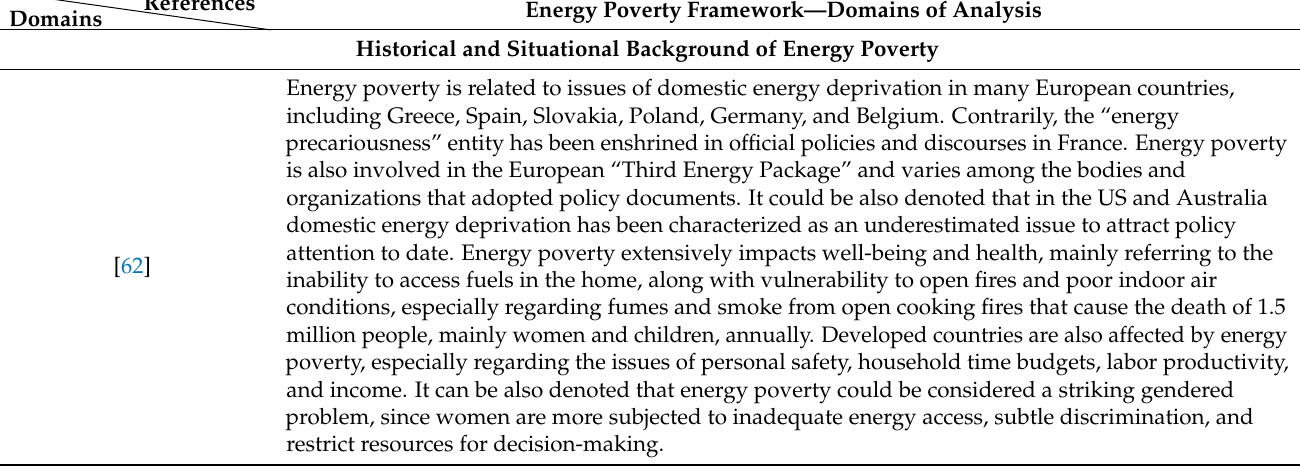
Table 3. Energy poverty overview (Source: authors own